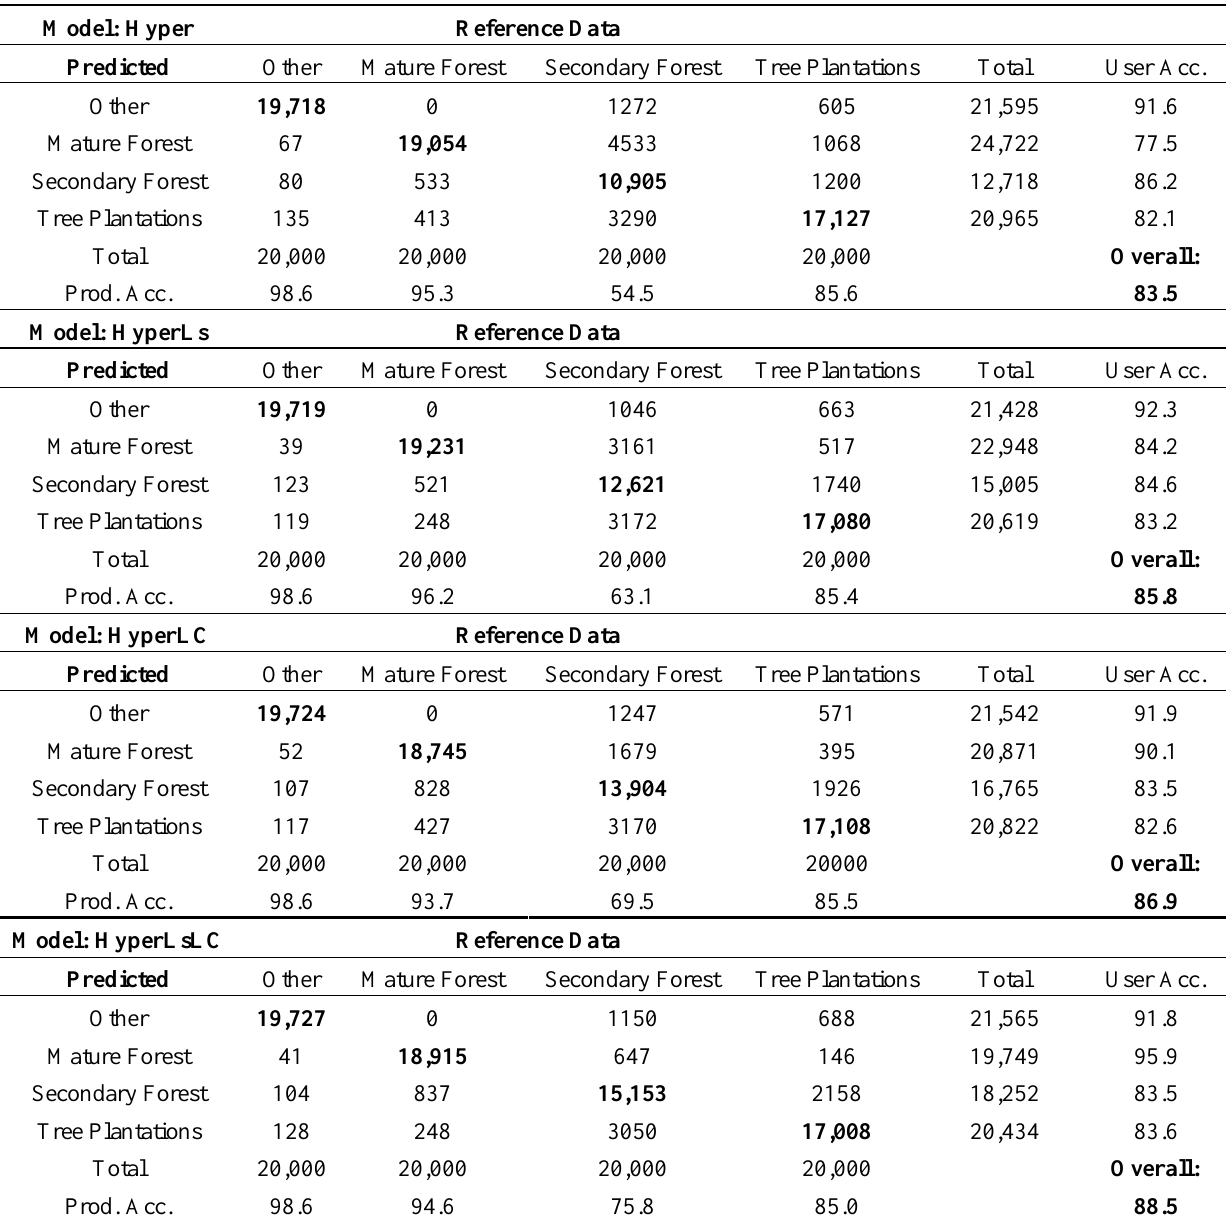
Table A2. Bootstrapped confusion matrices for forest summary classes, comparing all RF models to the base Hyper